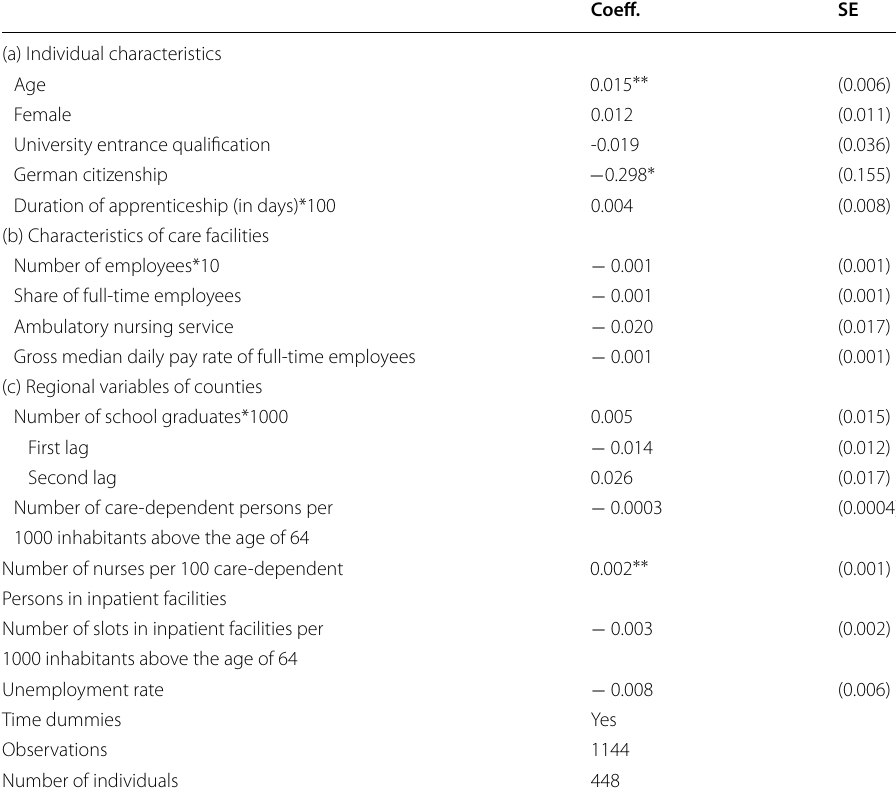
Table 6 The balance of the treatment: The probability of being in the treatment group for the pre- reform periods by characteristics of graduates, care facilities, and